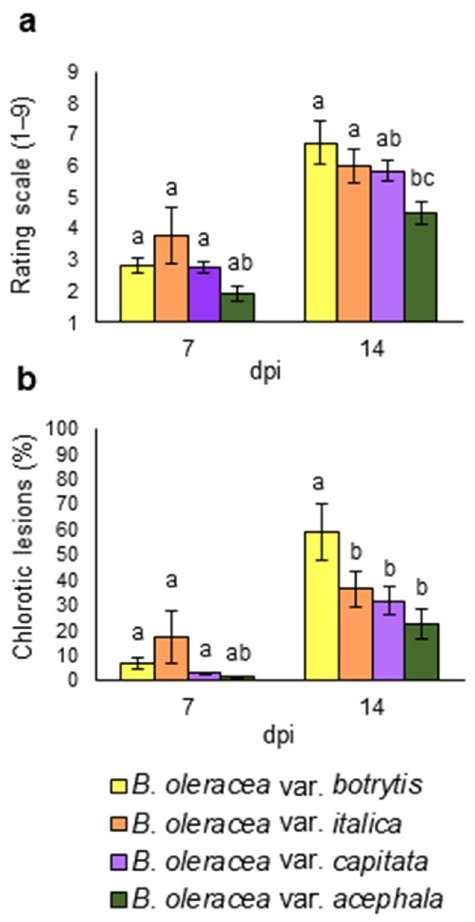
Figure 3. Resistance parameters from four different Brassica oleracea crops: B. oleracea var. botrytis , B. oleracea var. italica, B. oleracea var. capitata , and B. oleracea var. acephala , inoculated with Xanthomonas campestris pv. campestris under greenhouse conditions, at 7 and 14 days post inoculation (dpi). ( a ) Damage score and ( b ) lesion percentage. Data represent the averages of 3 repetitions. Different letters indicate significant differences at p < 0.05. Error bars indicate the standard errors.